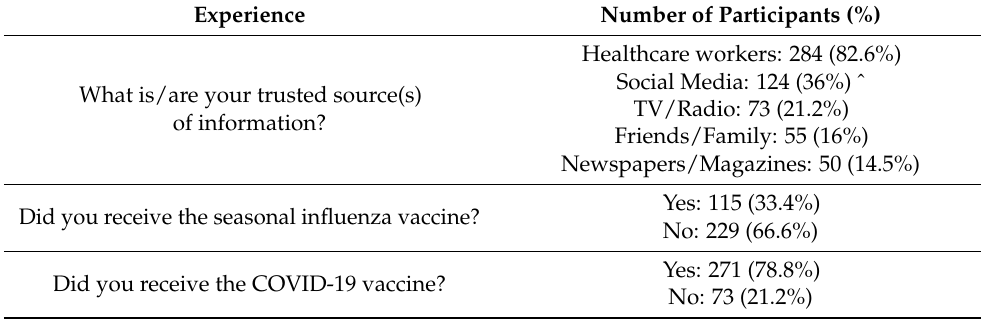
Table 2. The study participants’ trusted source of information and previous vaccination experience. Experience Number of Participants (%) Healthcare workers: 284 (82.6%) What is/are your trusted source(s) of information?